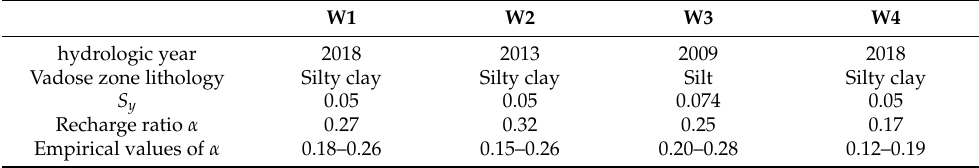
Table 8. Recharge ratio calculated using the WTF method.